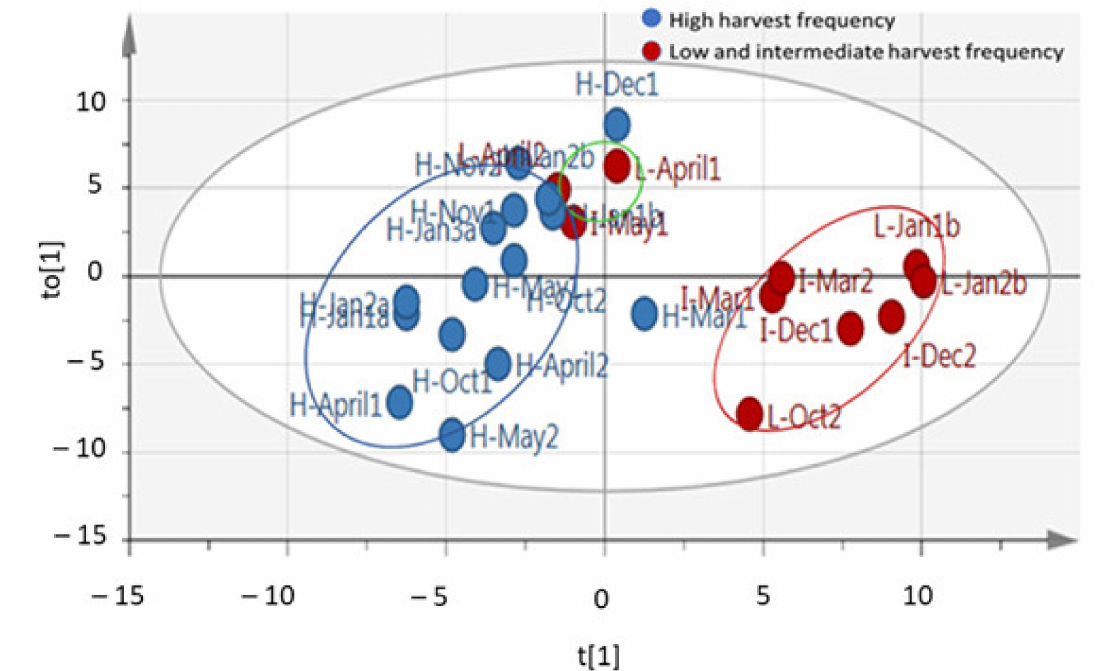
Figure 2. Orthogonal partial least square discriminatory analysis (OPLS-DA) score plot showing the predictive (t[1]) and orthogonal (to[1]) components of 1 H-NMR spectral data of M. oleifera (cultivar PKM1) metabolites profile under low/intermediate and high harvesting frequencies, showing three distinct clusters (R 2 X = 0.832; R 2 Y = 0.643; Q 2 = 0.371). R 2 X, R 2 Y, and Q 2 represent the cumulative values of all the components of the model. Low and intermediate harvest frequency (red circled), high harvest frequency (blue circled), and low and intermediate frequency samples harvested in April and May (green circled). H-30 days harvesting frequency; I-60 days harvesting frequency; L-90 days harvesting frequency; Jan-a = January, A = April, Mar = March, May = May, Oct = October, Nov = November, Dec = December; Jan-b–January of the next year. R 2 X[1] = 0.472; R 2 Xo[1] = 0.358.